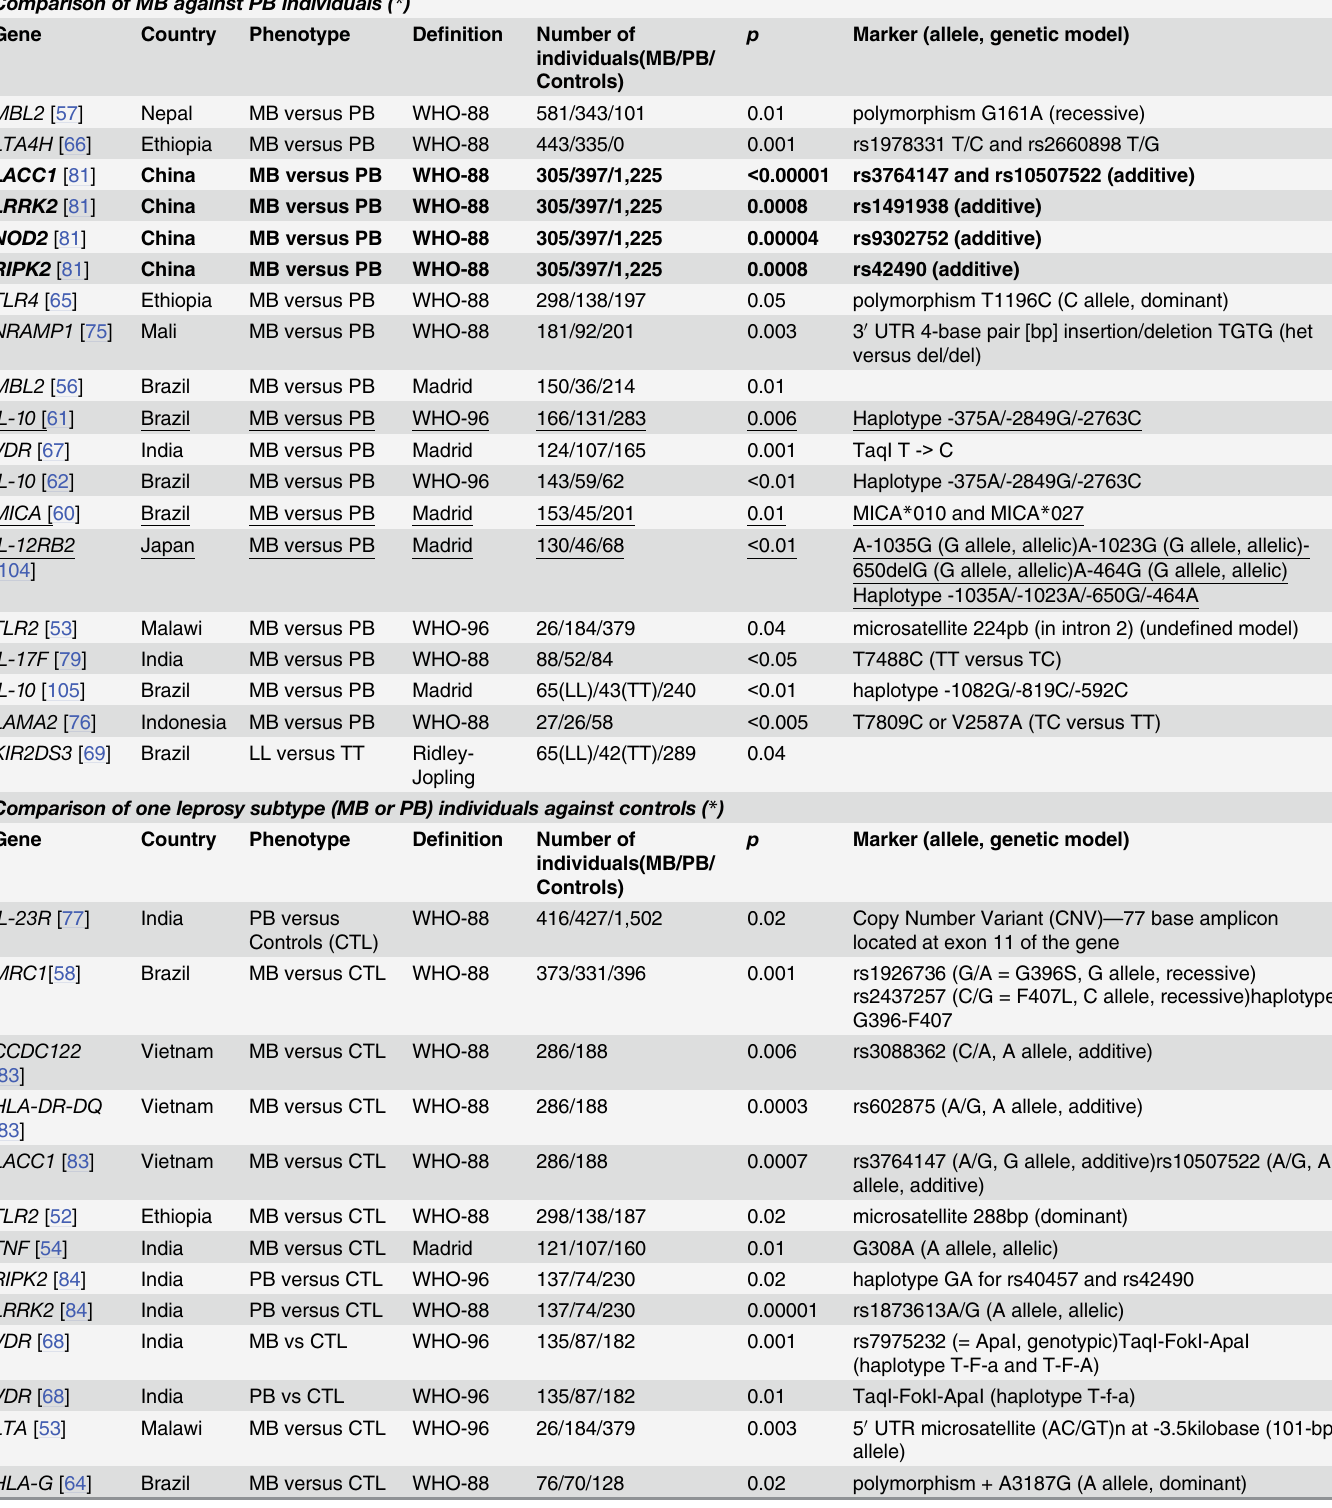
Table 1. Studies identifying 28 genes associated with clinical forms of leprosy or its polarization. Comparison of MB against PB individuals ( *